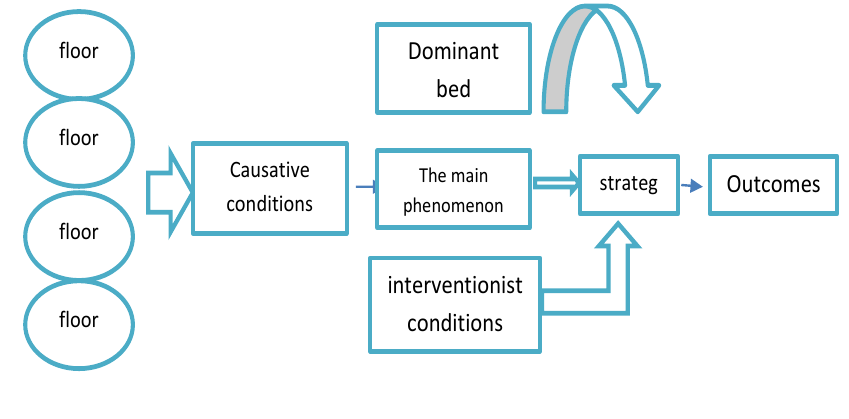
Fig1. Axial coding paradigm